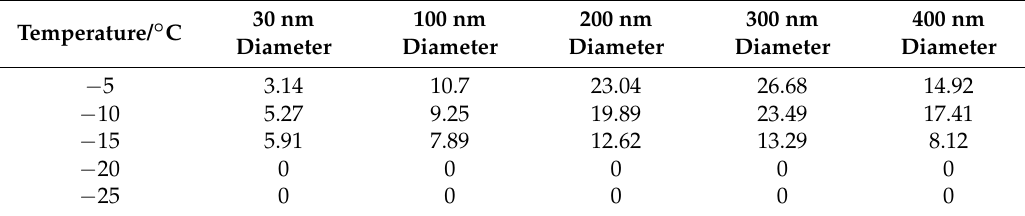
Table 4. The frosting weight reduction rate of the nanoporous diameter aluminum plates compared to the polished aluminum plate at the ambition relative humidity was 90%.